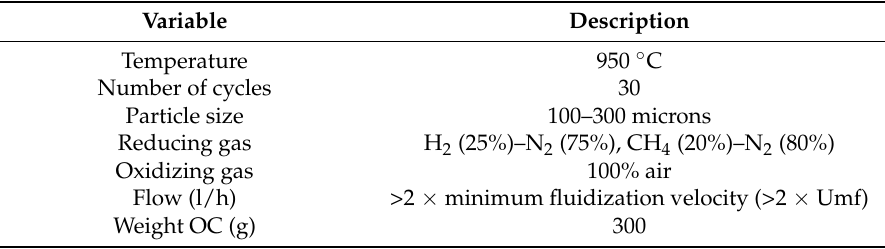
Table 2. Operating conditions for obtaining